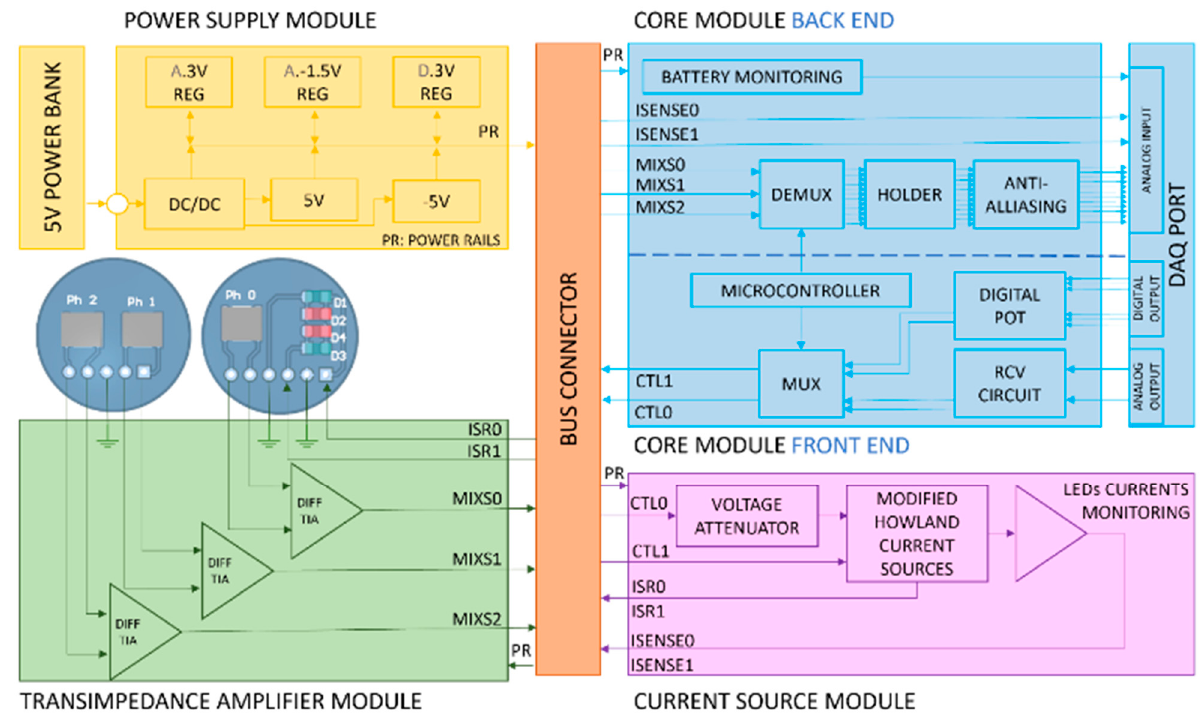
Figure 2. Detailed block diagram showing the ZenTBI architecture, considering the power supply module, core module, current source module, transimpedance amplifier module, and bus board.